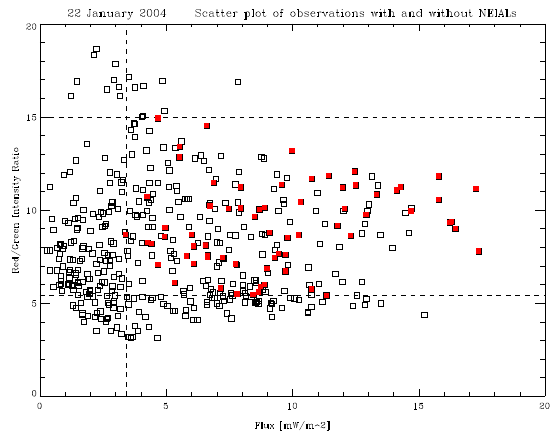
Fig. 6. The energy flux versus the intensity ratio of 630.0/557.7. The red filled squares represent NEIALs